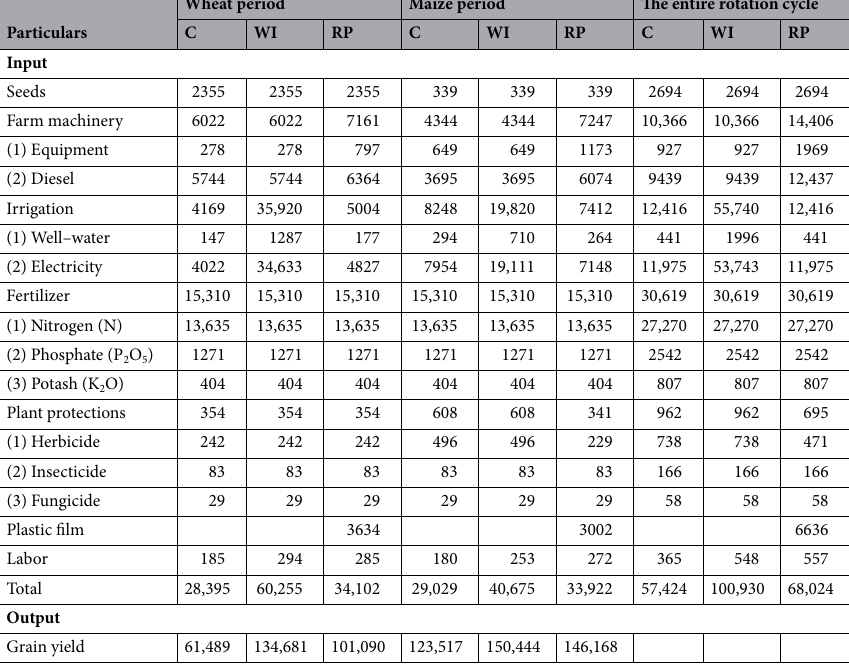
Table 2. Effect of different planting strategies on annual average energy inputs and outputs (MJ ha –1 ) of wheat–maize cropping system. C, conventional rain–fed flat planting; WI, well-irrigation planting; RP, ridge- furrow planting with plastic film mulch over the ridge. Data are averaged over the two growing